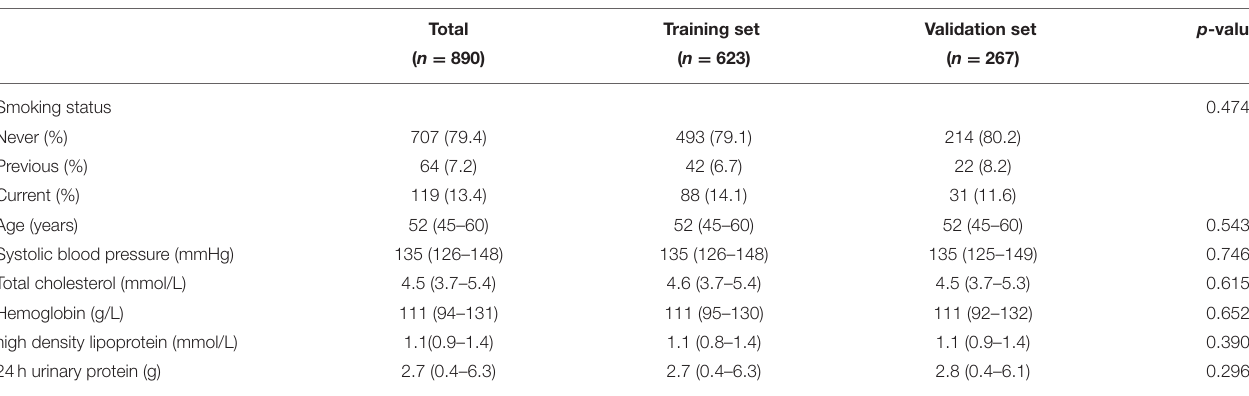
TABLE 1 | Baseline characteristics in the training set and validation